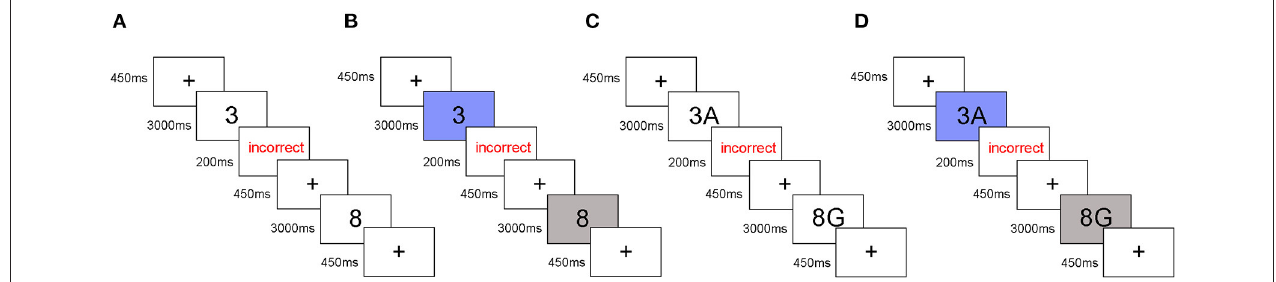
FIGURE 1 | Experimental timeline of task-switching paradigm. (A) The predictable parity/magnitude task. (B) The unpredictable parity/magnitude task. (C) The predictable parity/vowel-consonant task. (D) The unpredictable parity/vowel-consonant